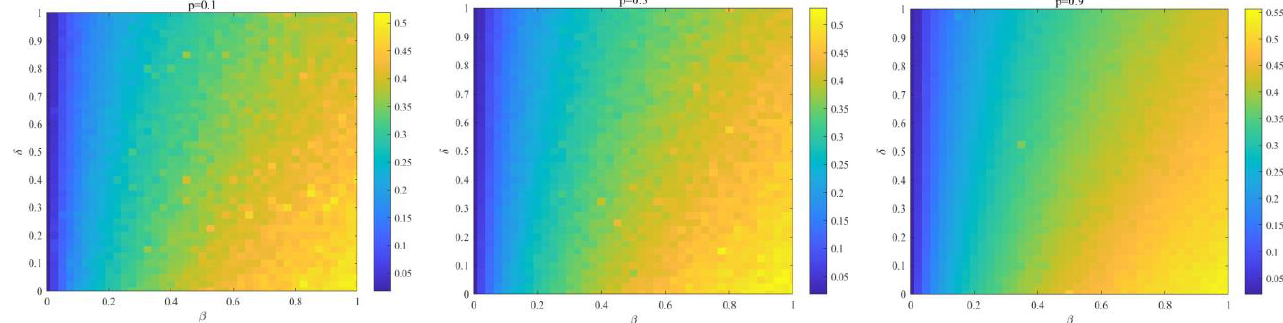
Figure 8. The full-phase diagram δ − β for different values of p . The color represents the proportion ρ R of recovered enterprise under steady state, other parameters are set as α = 5, m = 2, m 1 = 5, m 2 = 7, κ = 2, η = 0.8, µ = 0.8, λ = 0.8, γ = 0, θ = 0.